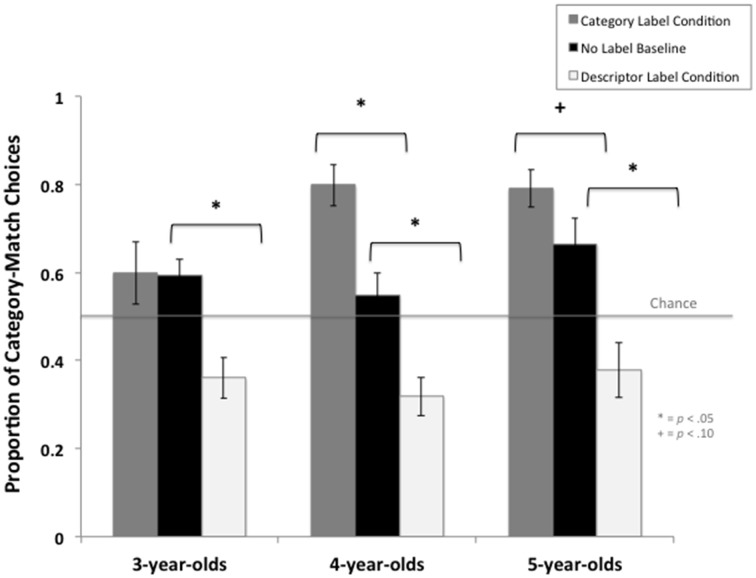
Summary of children's performance on the Property Induction Task as a function of label condition (Category Label, No Label Baseline, and Descriptor Label conditions) across age groups. Error bars represent the standard errors of the mean. Line indicates chance performance (0.50). *p-value < 0.05;